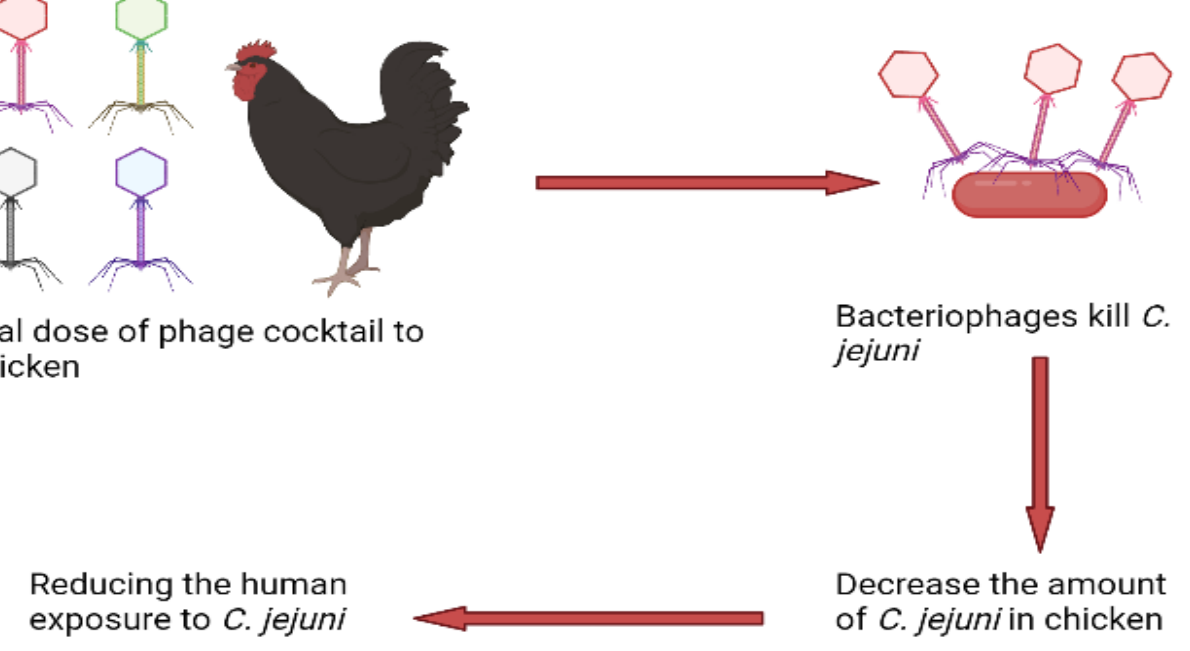
Figure 1. Mechanism of the phage cocktail to kill the C. jejuni . Orally administered phage cocktail to infected chicken. The phages kill the C. jejuni and decrease the level of C. jejuni in chickens. As a result, reduced human exposure and morbidity.